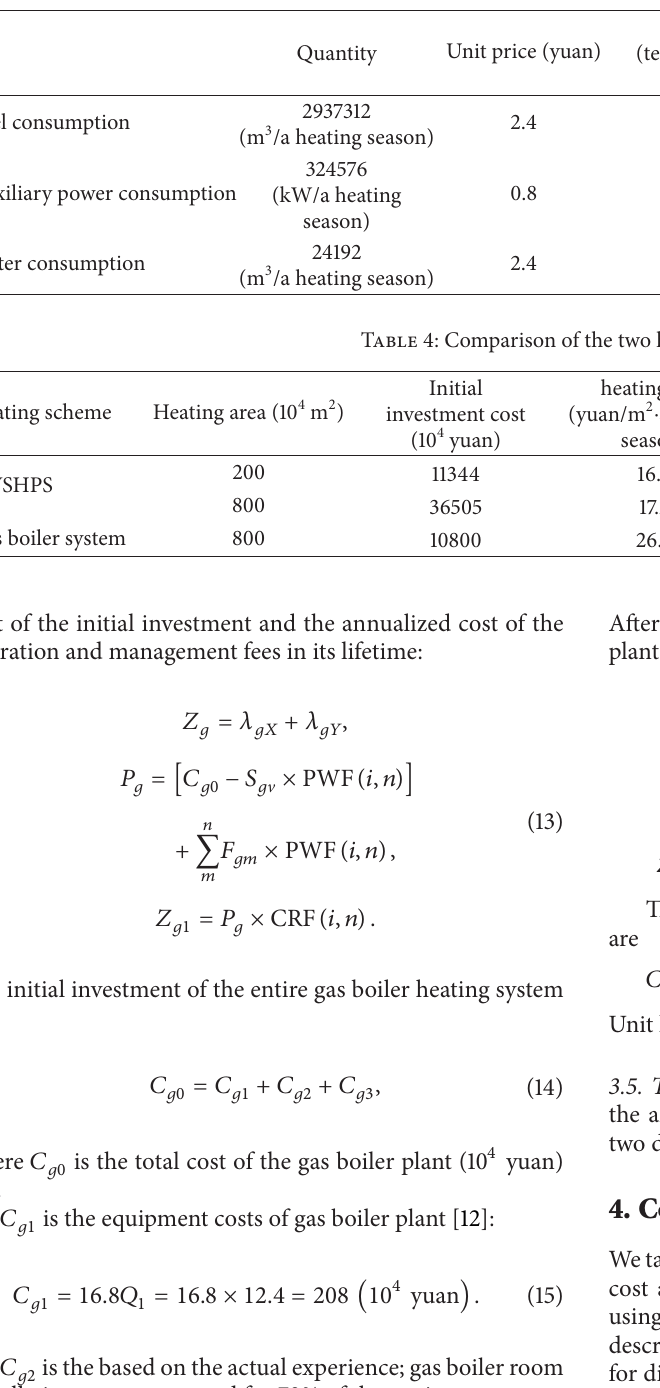
Table 3: The energy cost of the gas boiler system.